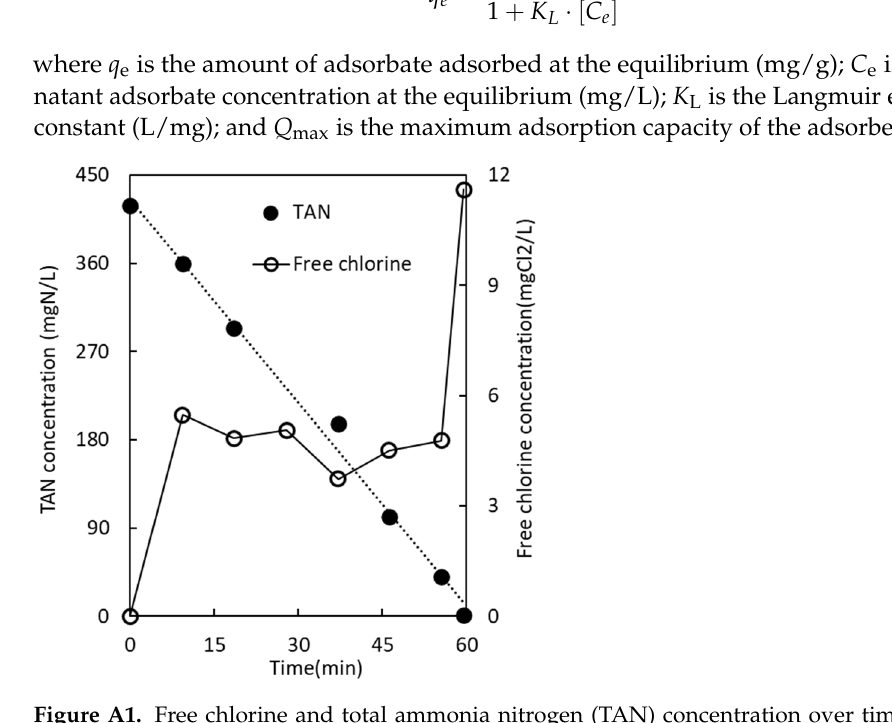
Figure A1. Free chlorine and total ammonia nitrogen (TAN) concentration over time during an electrolysis run on the 2nd batch of real wastewater (WW) experiment, cycle #3, with a current efficiency of 92.9% (I = 26.1 A, V = 3.3 V).